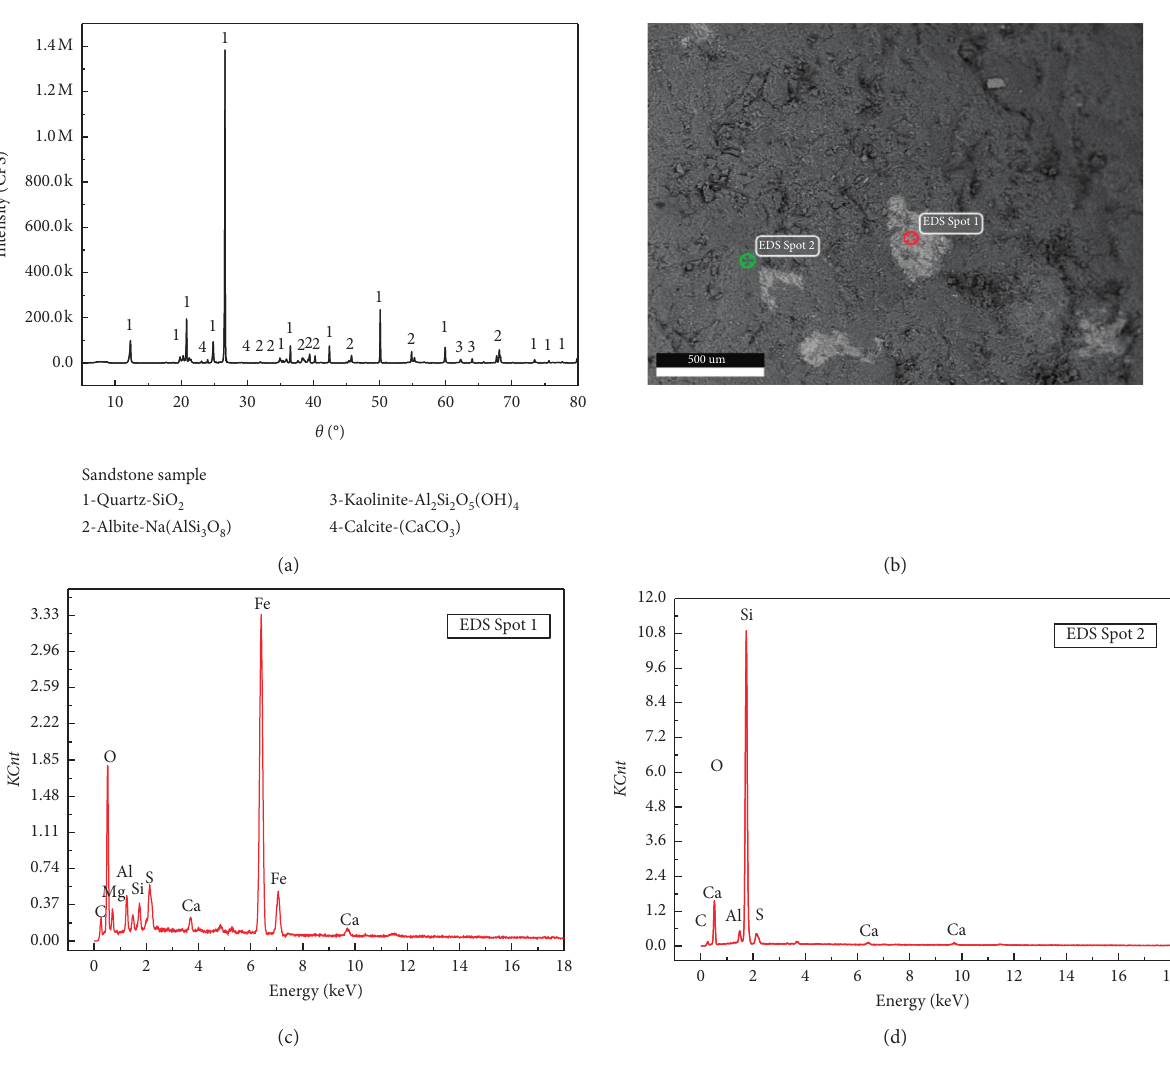
Figure 2: XRD and EDS observation of sandstone: (a) XRD spectrum (15 ° C), (b) EDS spots (15 ° C, 500 μ m), (c) Spot1 element analysis, and (d) Spot 2 element analysis.